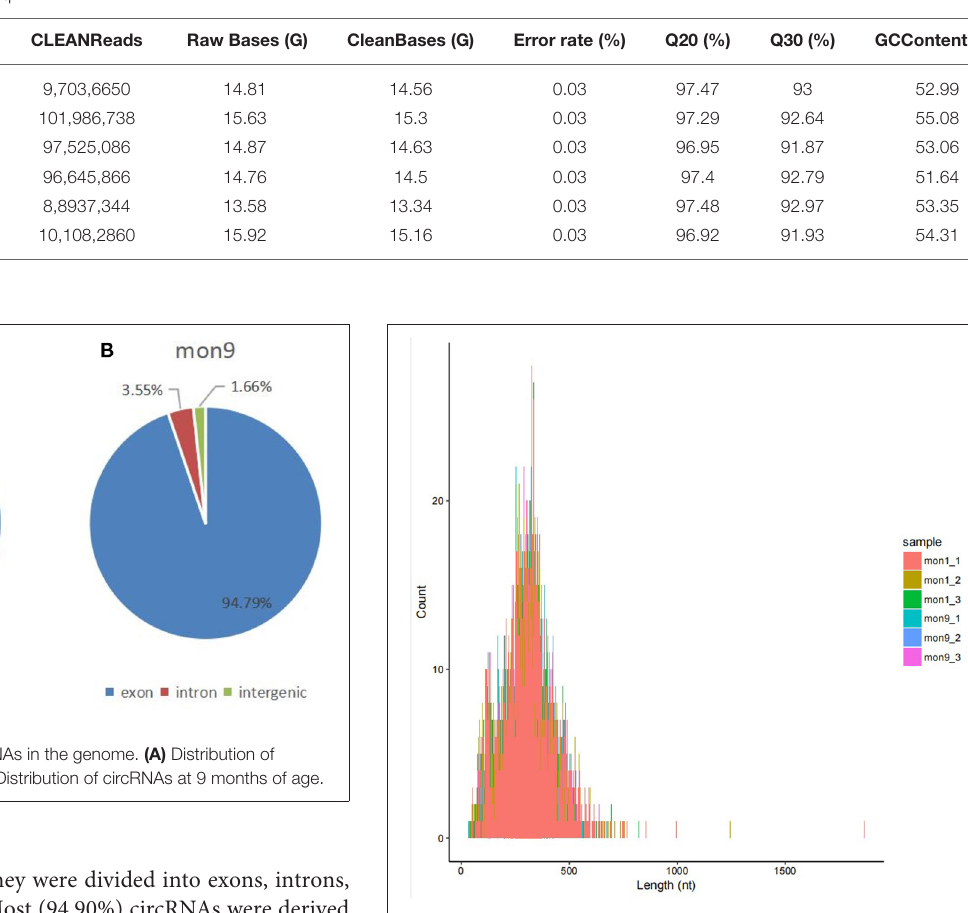
FIGURE 3 | Circos diagram of the density distribution of all circRNAs on the chromosomes of each